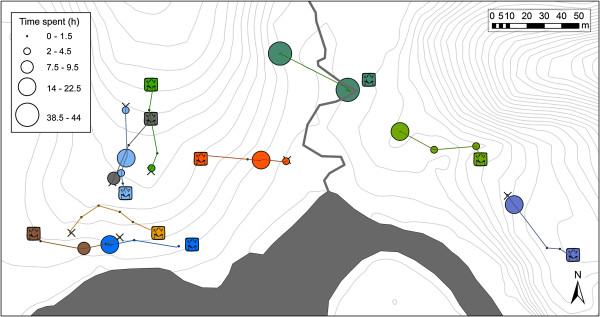
Trajectory map. Map of the study area showing homing trajectories and temporal distribution of ten territorial males, each individual represented by a different color. Square frog symbols indicate the home territories; x-symbols show release points; circles show en route locations connected with linear interpolation lines. The size of each circle is proportional to the time spent at each location. Contour lines (1 m) are in light gray, creeks and Arataye River in dark gray.